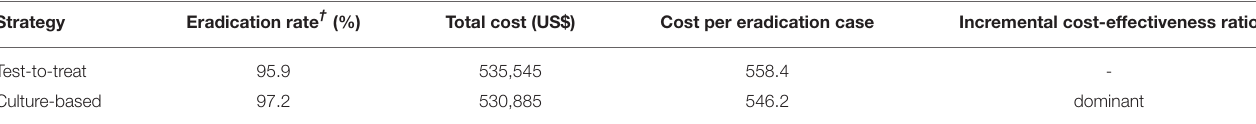
TABLE 1 | The eradication rates, total cost to treat 1,000 patients, and cost per eradication with both eradication strategies. Strategy Eradication rate † (%) Total cost (US$) Cost per eradication case Incremental cost-effectiveness ratio 95.9